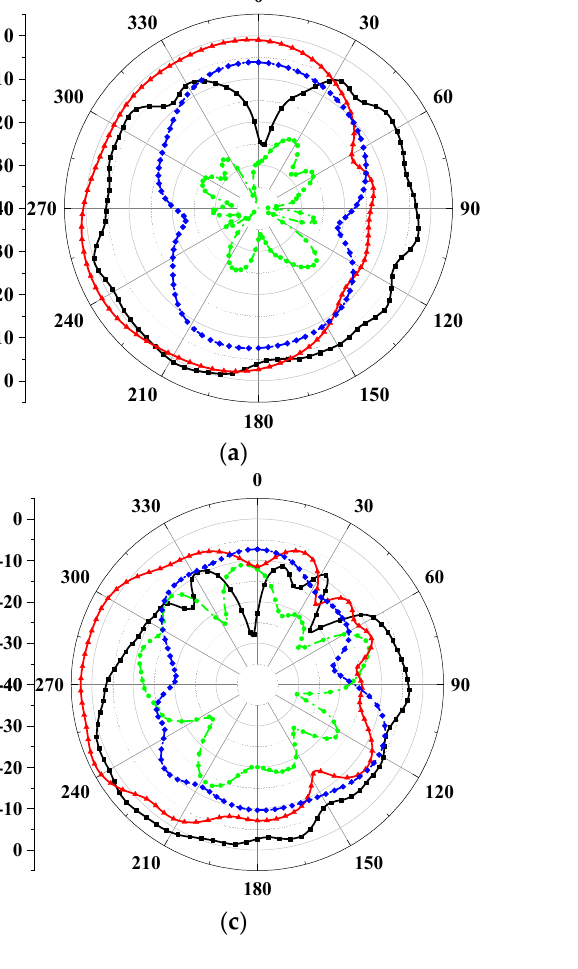
Figure 13. Measured and simulated 2D radiation charts of ( a ) E-plane at 3.4 GHz; ( b ) H-plane at 3.4 GHz; ( c ) E-plane at 4.9 GHz; ( d ) H-plane at 4.9 GHz.